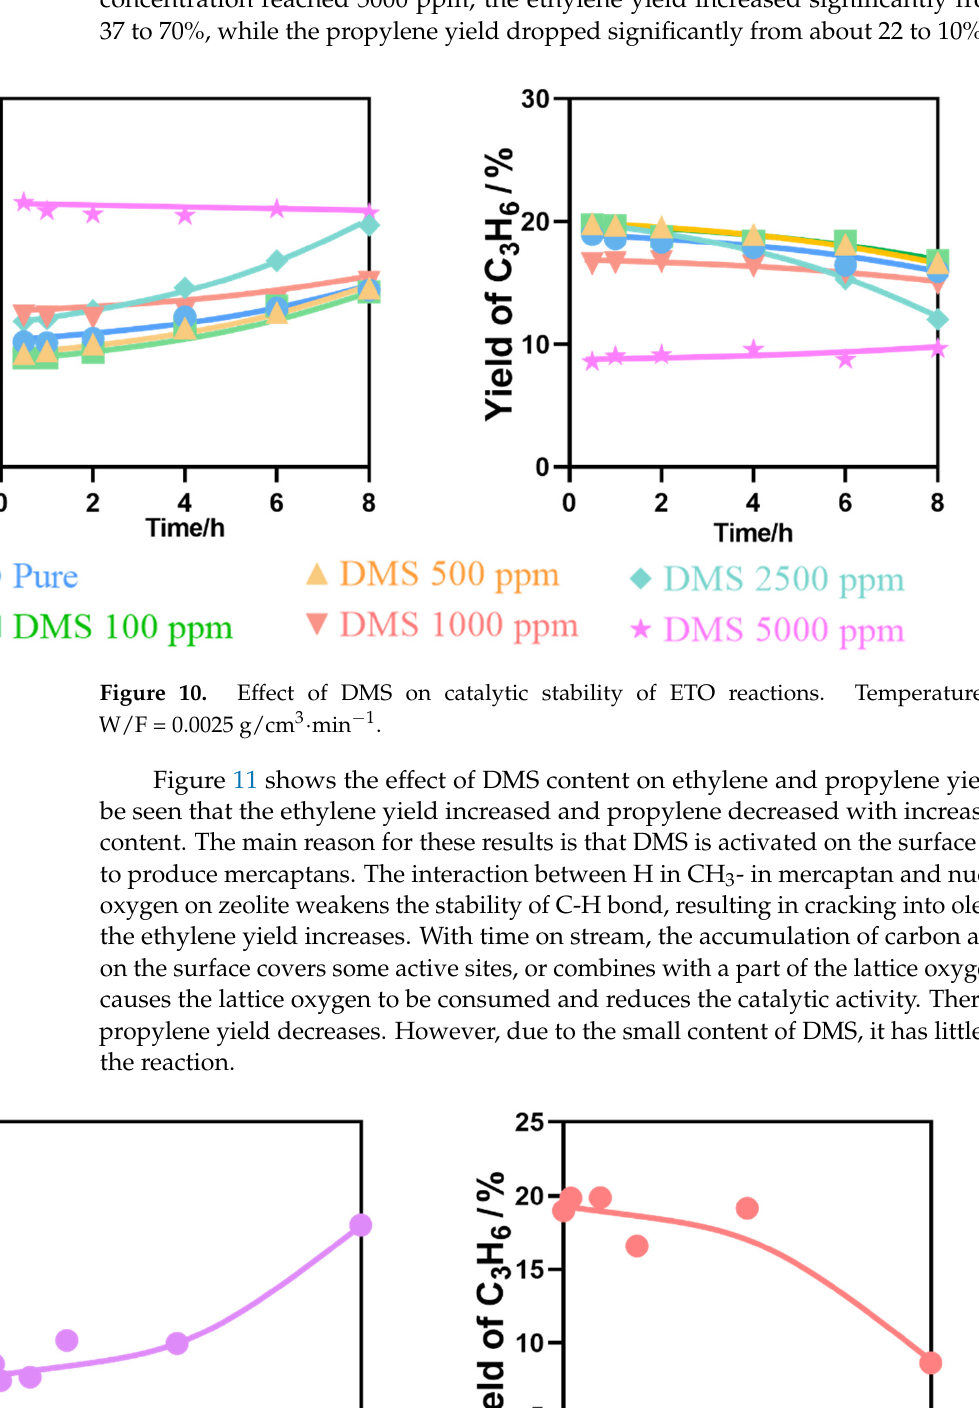
Figure 12. Ethylene and propylene yields of regent-grade ethanol and bioethanol catalytic conversions. Temperature, 400 °C; W/F = 0.0025 g/cm 3 ·min − 1 . 4. Conclusions The catalytic reactions of ETP were systematically investigated on different zeolite catalysts. Among the zeolites investigated, H-ZSM-5(80) exhibited the most efficient performance for propylene production. Therefore, the effects of reaction conditions such as reaction temperature and calcination temperature on H-ZSM-5(80) were studied. The moderate acidic sites on ZSM-5 are required for the product of propylene. The activity of ZSM-5 was independent of ethanol feed composition. The H-ZSM-5(80) catalyst was found to be deactivated during ethanol conversion by dealumination, which was caused by water generated from ethanol dehydration. A plausible reaction pathway was proposed. The effects of DMS on ETP reaction were further analyzed, and it was found that DMS did not cause any major deactivation of the H-ZSM-5(80) catalyst. The HZSM- 5(80) catalyst is therefore suitable not only for ethanol but also for bioethanol conversion to propylene. Supplementary Materials: The following supporting information can be downloaded at: https://www.mdpi.com/article/10.3390/nano12162746/s1, Figure S1: NH 3 -TPD profiles of H-ZSM- 5(80) catalysts calcined at different temperatures; Figure S2: NH 3 -TPD profiles of H-ZSM-5(80) catalysts of fresh and post reaction (8 h reaction) H-ZSM-8(80) catalysts.